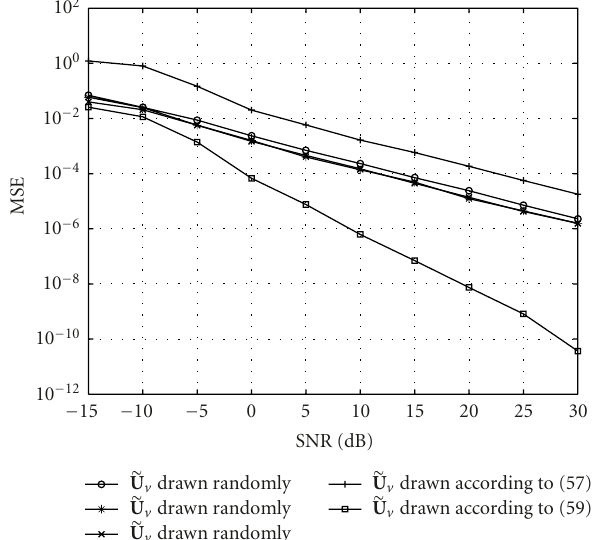
Figure 7: MSEs of the estimated channel versus SNR for e o = 28 and di ff erent matrices Σ v . The BP algorithm.